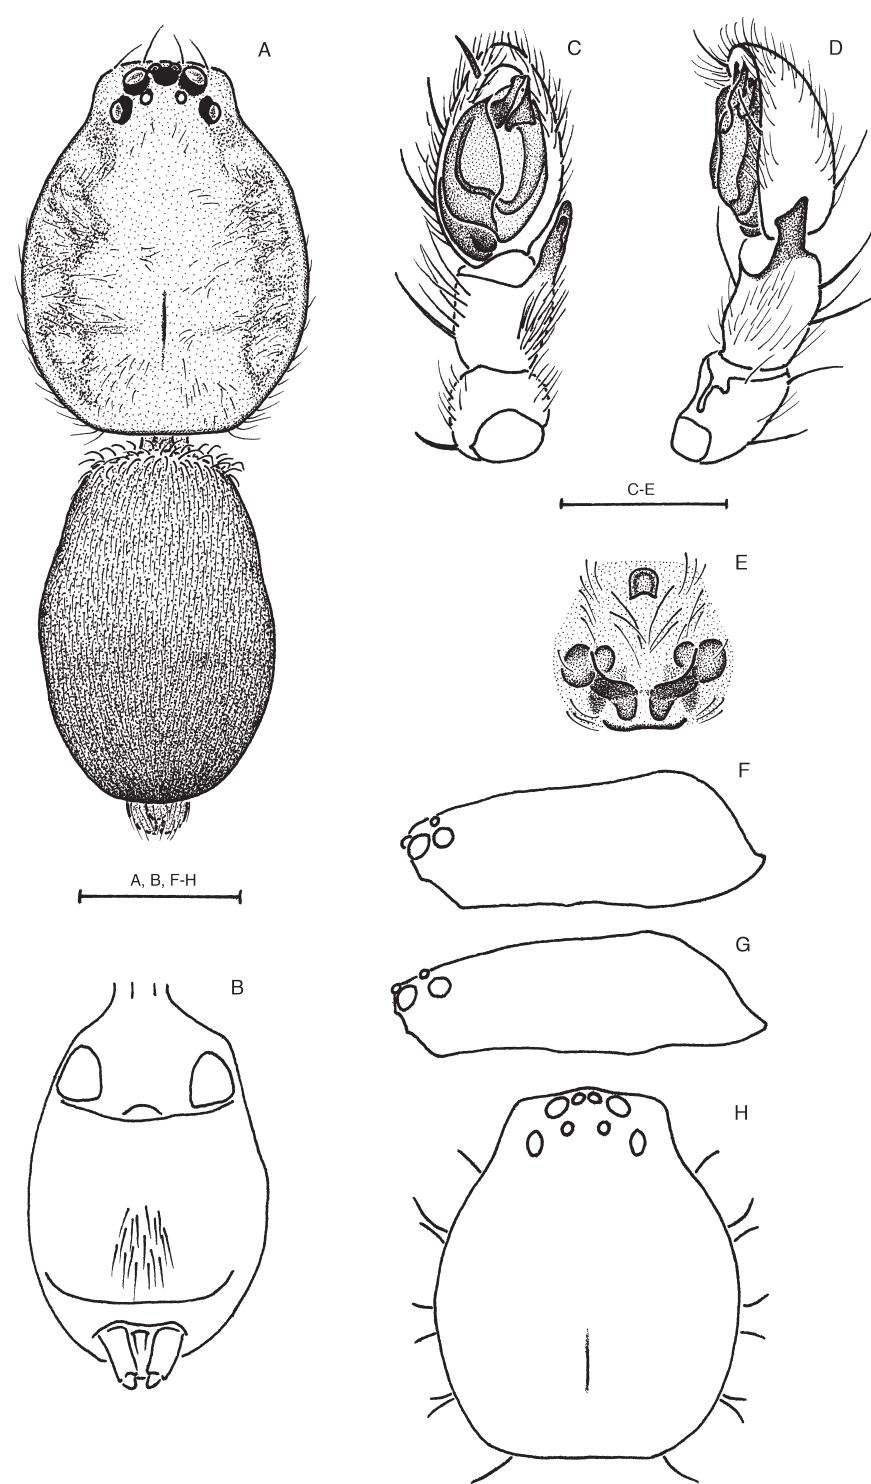
Fig. 9. Cteniogaster toxarchus gen. et sp. nov. A. ♂, habitus, dorsal view. B. Idem, abdomen, ventral view. C. Idem, palp, ventral view. D. Idem, retrolateral view. E. Epigyne, ventral view. F. ♀, carapace, lateral view. G. ♂, carapace, lateral view. H. ♀, carapace, dorsal view. Scale bars: A-C, F-H = 0.5 mm, C-E = 0.25